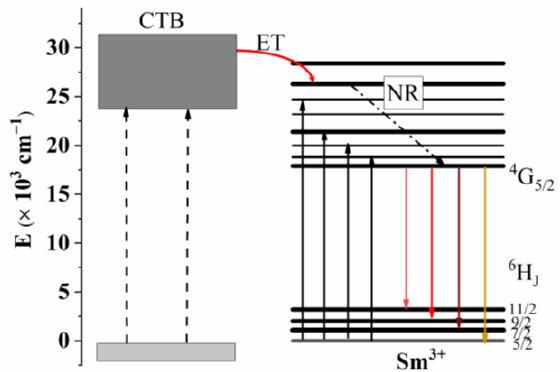
Figure 4. Schematic diagrams of Sm 3+ charge transfer band (CTB) in Lu 2 MoWO 9 . The PL excitation (left part) and emission (right part) spectra of the three samples of Sm 3+ doped Lu 2 Mo 0.5 W 0.5 O 6 , Lu 2 MoWO 9 , and Lu 2 (Mo 0.5 W 0.5 O 4 ) 3 are illustrated in Figure 5. The Lu 2 MoWO 9 sample presented the strongest excitation and emission intensities. The CTB band was located at about 368 nm, and the strongest emission was located at about 614 nm. Compared to those of Lu 2 MoWO 9 , the Lu 2 Mo 0.5 W 0.5 O 6 illustrated weaker PL excitation and emission intensities, the excitation and emission intensities of Lu 2 MoWO 9 were about 4.5 times of those of Lu 2 Mo 0.5 W 0.5 O 6 . The Sm 3+ doped Lu 2 (Mo 0.5 W 0.5 O 4 ) 3 presented the weakest CTB intensity and the absorption peak located at about 288 nm. On the one hand, in the Lu 2 Mo 0.5 W 0.5 O 6 and Lu 2 MoWO 9 phosphors, the CTB absorption intensities were much stronger than those of the 4f–4f excitation from Sm 3+ . On the other hand, the situation was the opposite. In the Lu 2 (Mo 0.5 W 0.5 O 4 ) 3 material, the intensity of the PL excitation from Sm 3+ 4f – 4f was stronger than that of CTB. With 405 nm excitation, the Lu 2 (Mo 0.5 W 0.5 O 4 ) 3 presented the strongest emission at about 600 nm and the different splits of those of Lu 2 MoWO 9 and Lu 2 Mo 0.5 W 0.5 O 6 , which illustrated that the Sm 3+ was located at different crystalline sites.